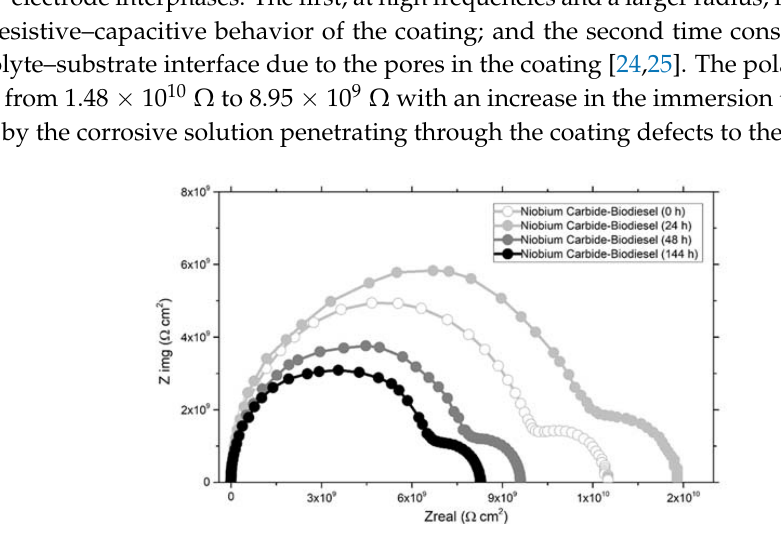
Figure 10. Nyquist diagrams obtained via EIS on the niobium carbide coating in contact with palm biodiesel at 291 ± 2 K at different exposure times.